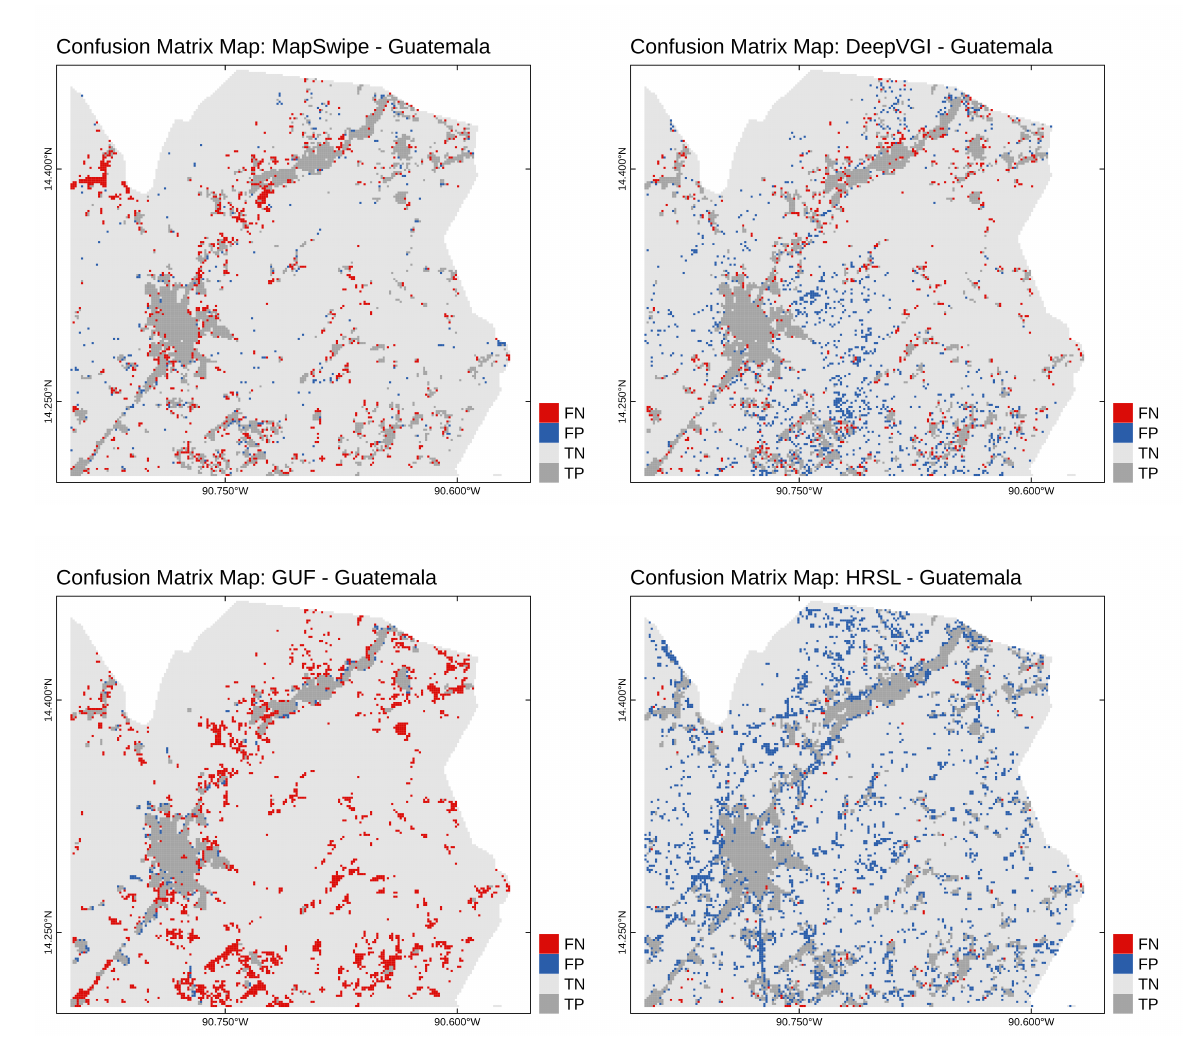
Figure 3. Map representation of the confusion matrix for Guatemala: Each map shows the spatial distribution of correct “building” (TP) and “no building” (TN) classifications for a specific method in the testing area. Incorrect classifications are split into false positives (FP) and false negatives (FN). Each pixel corresponds to a single task/satellite imagery